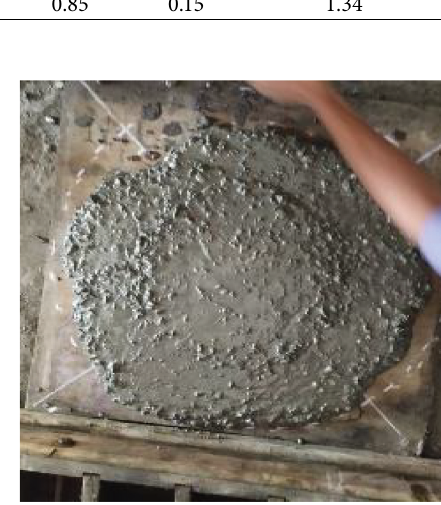
Figure 4: Slump flow test. Figure 5: J-ring test.